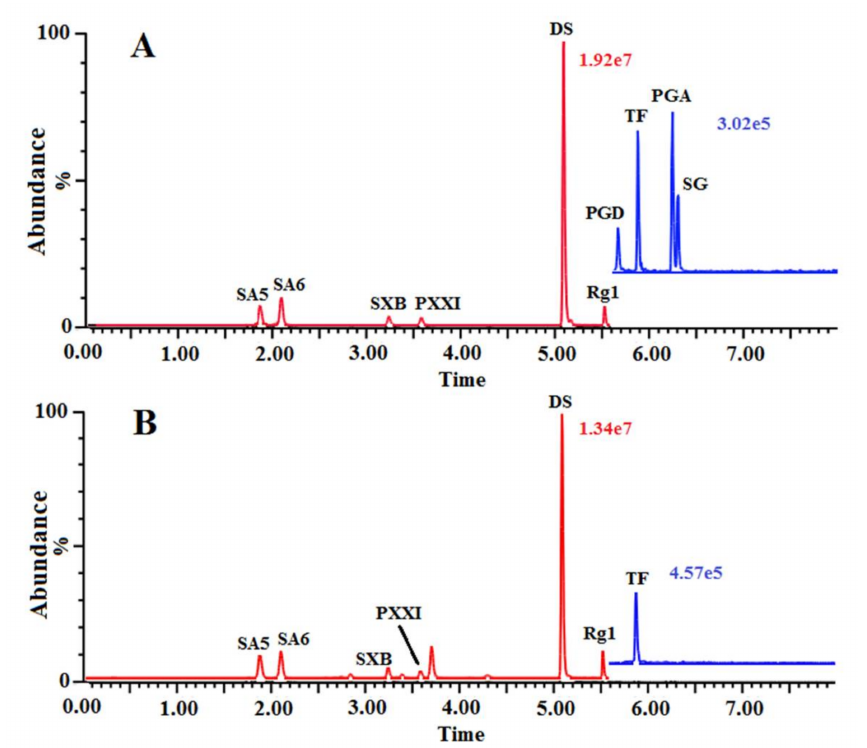
Figure 1. The representative MRM chromatograms of the reference standards solution ( A ) and sample solution ( B